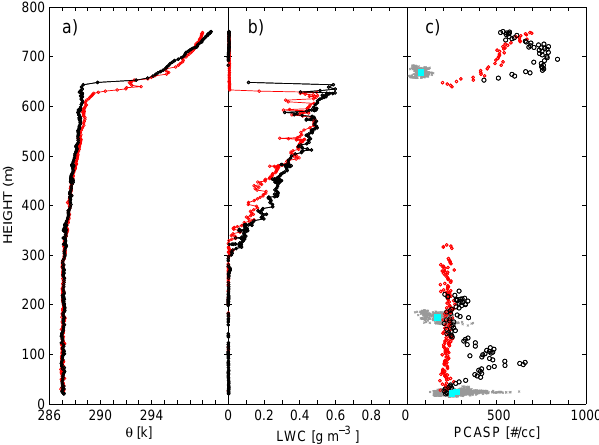
Figure 3. Profiles of (a) potential temperature ( θ , K), (b) liquid water contents (LWC, gm − 3 ), and (c) accumulation mode aerosol concentrations (#/cc, PCASP) during the aircraft ascent (black) and descent (red) between 16:52:15 and 17:10:48UTC (hh:mm:ss). Aerosol concentrations obtained from sub-cloud layer and above cloud layer are shown as grey colors (mean value is shown as cyan square). The heights and spatial locations of data used are shown in Fig. 4. PCASP resolves particles in diameter ranges from 0.1 to 3µm.